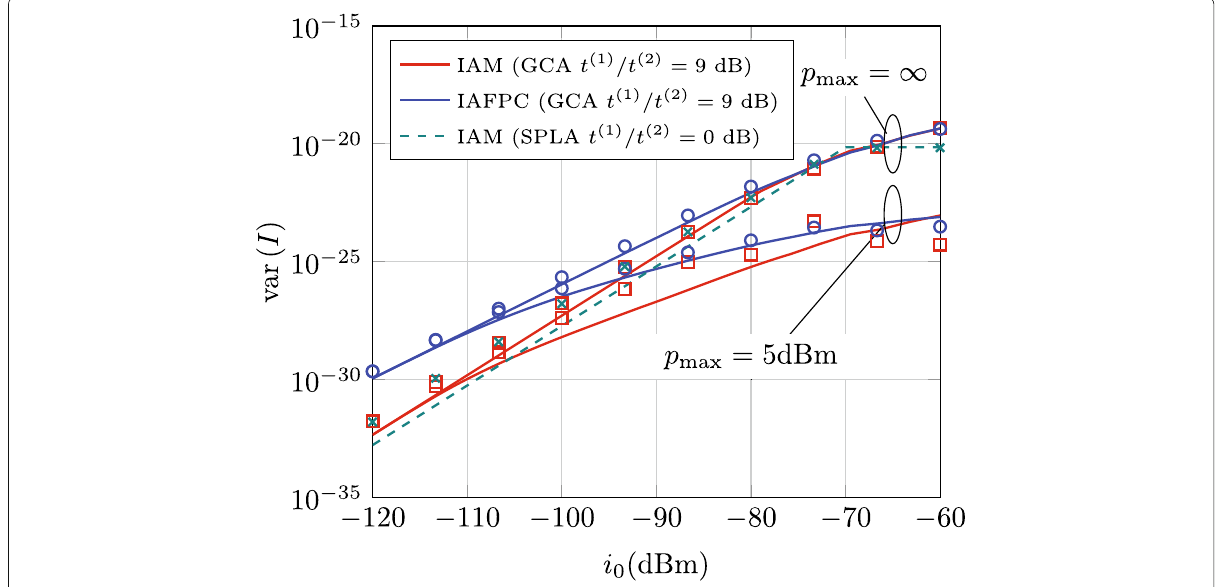
Fig. 4 Variance of the interference versus i 0 for IAM and IAFPC schemes with (cid:5) = 1, p max → ∞ , and p max = 5